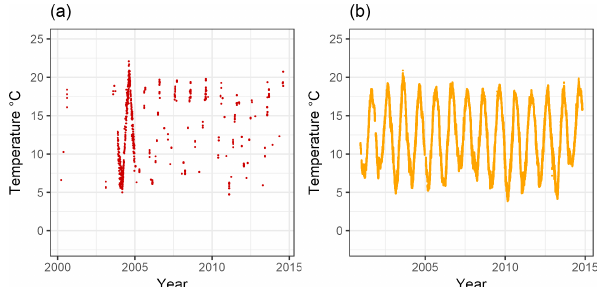
Figure 12. Plot of seawater temperature in the southern North Sea against time post-2000. (a) Data from sources other than au- tonomous platforms. (b) Data from the two autonomous monitoring stations in the selected area.